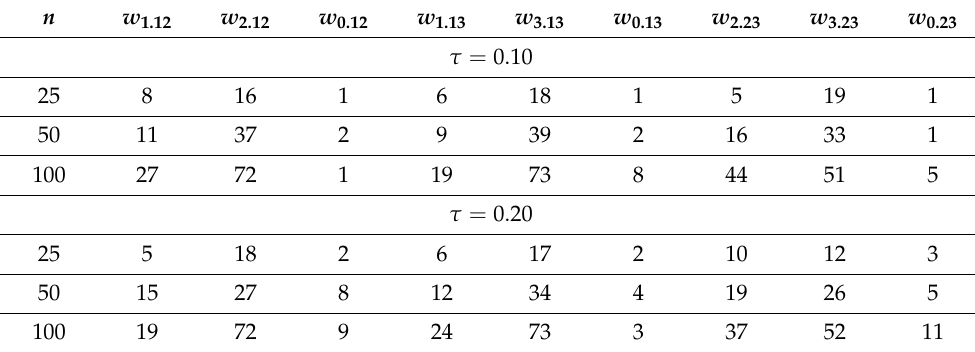
Table 2. Artificial data under the preset experimental states.